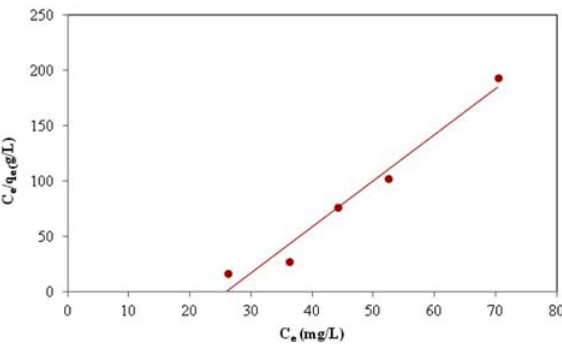
Figure 12. Langmuir isotherm of AY